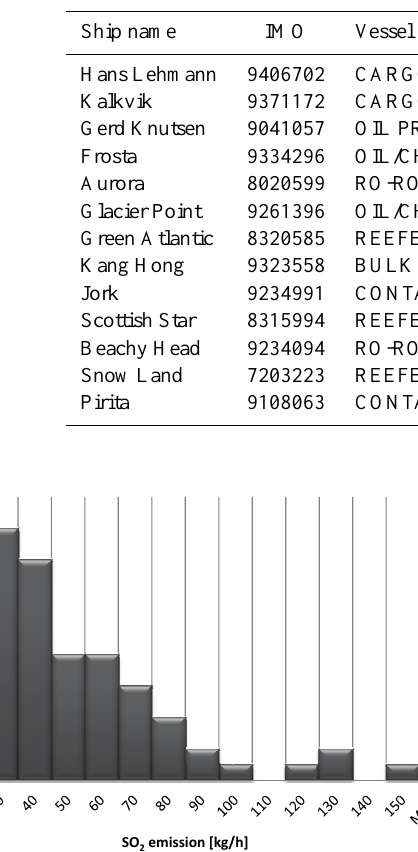
Table 2. Optical SO 2 measurements of ship emission rates performed on the Baltic sea outside Gotland on 5 days between 13 and 24 Au- gust 2008. The acronyms in the header correspond to IMO number of ship, Dead Weight Ton (DWT), ship speed in knots ( v ), mean SO 2 emission ( E ) in kgh − 1 , and 1- σ emission variability (STD) in %.